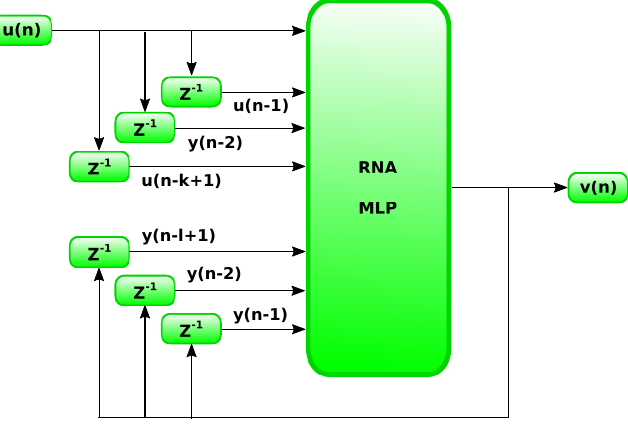
Figure 4. Example of NARX structure. Source: Adapted from Silva